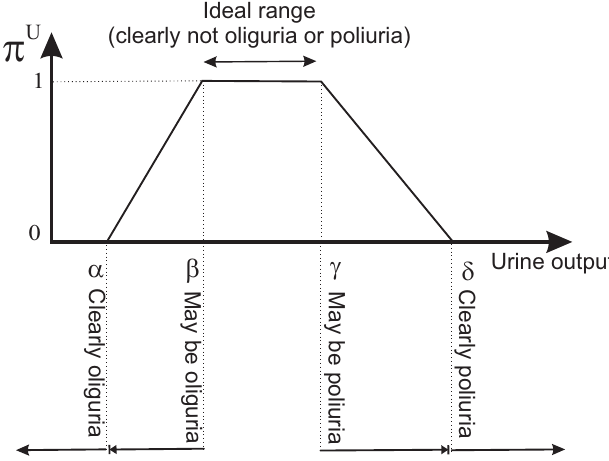
Figure 4. Trapezoidal possibility distribution representing the therapeutic goal for urine